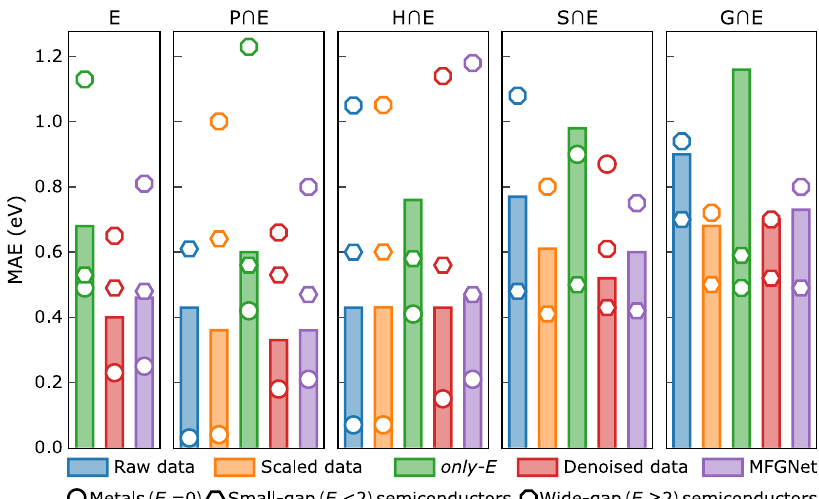
Fig. 2 MAE for the different approaches. The subplot on the left shows the MAE for all the available experimental data, the other subplots report the MAE for the different intersections P ∩ E, H ∩ E, S ∩ E, and G ∩ E. In each subplot, the MAEs are also indicated separately for the metal (circles), the small-gap ( E g < 2) semiconductors (hexagons), and the wide-gap ( E g ≥ 2) ones (octogons). The corresponding MAE values are provided in Supplementary Tables 1 – 5.